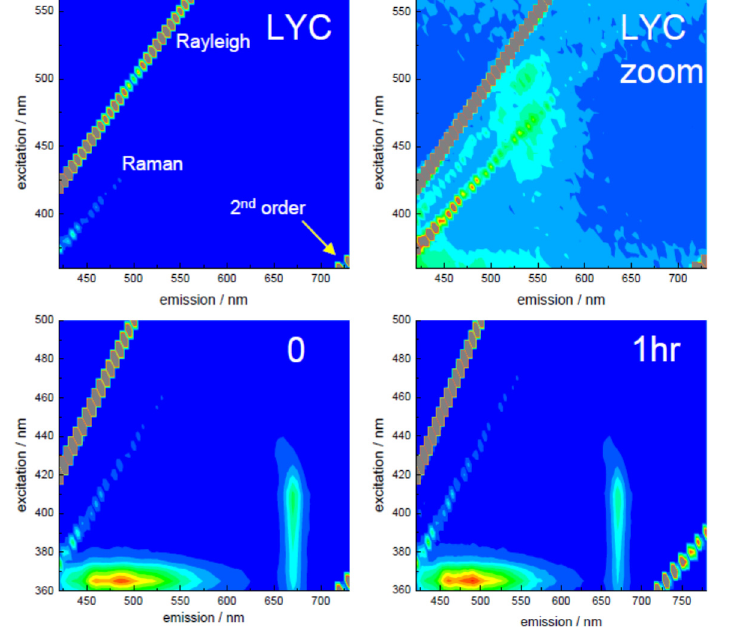
Figure 4. Fluorescence excitation-emission spectra (EEM’s) for the samples, showing excitation wavelength ( y -axis) emission wavelength ( x -axis) and the intensity as rainbow scale (red—high, blue—low). The lycopene EEM (LYC) has also been scaled (LYC zoom) to show the lower intensity emission at ~550 nm. The scattering positions relating to Rayleigh, Raman and second order are also indicated. Adapted from